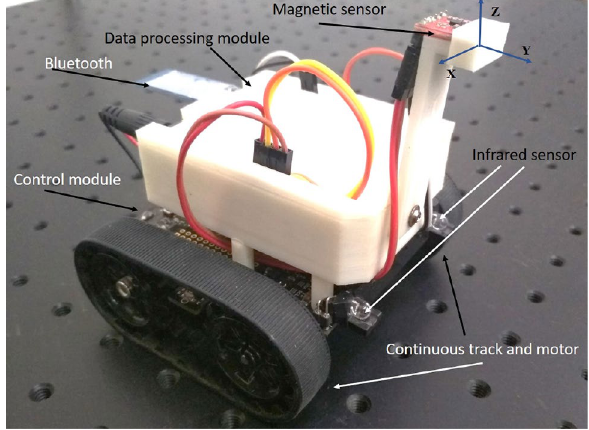
Fig. 2 Prototype executed for the inspection system of defects in ferromagnetic